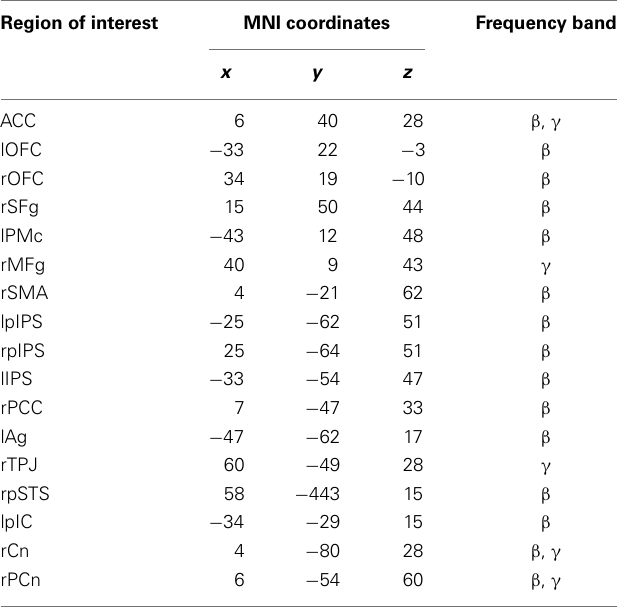
Table 1 | Montreal Neurological Institute coordinates of the maximum activity peak for regions of interest showing significant modulations of band power with respect to baseline (FDR